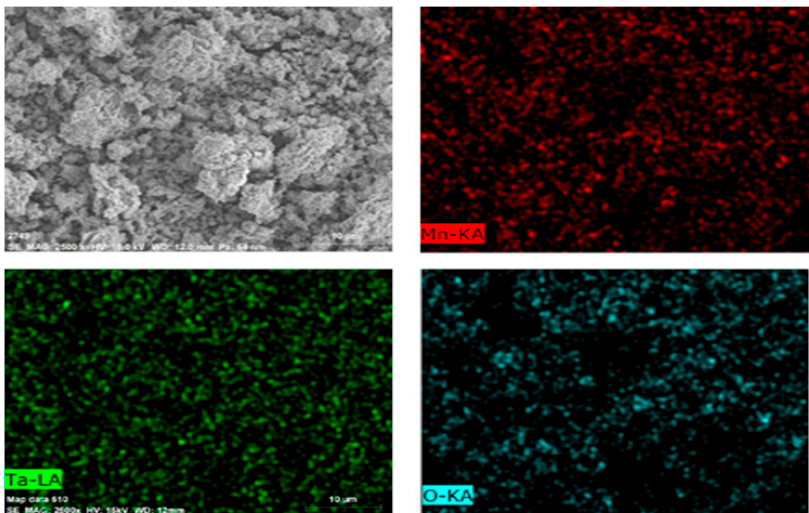
Figure 3. SEM-EDS analysis patterns of the solid electrolyte tantalum capacitors (SETCs) after pre-treatment.